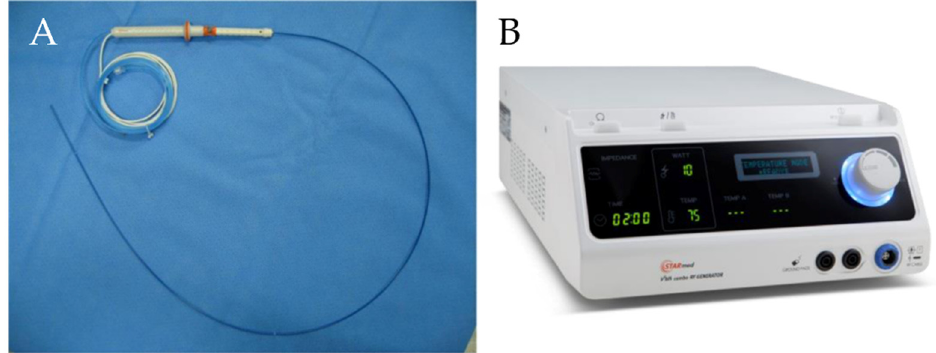
Figure 1. Endoscopic radiofrequency electrode and power generator (STARmed, Seoul, Korea). ( A ) 19-gauge endoscopic radiofrequency ablation electrode. ( B ) A VIVA radiofrequency power generator.